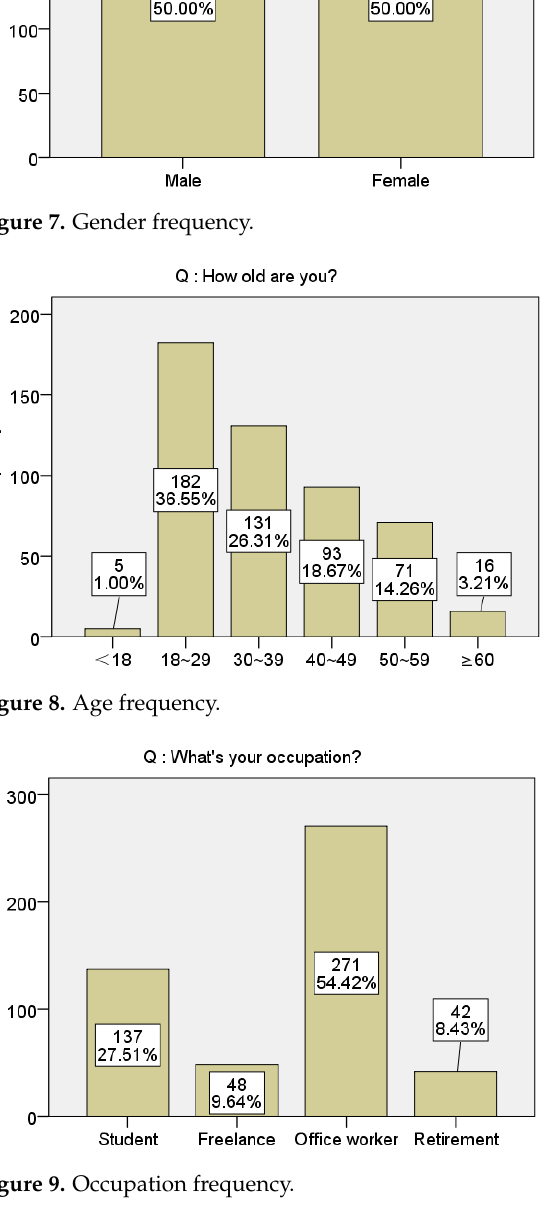
Figure 9. Occupation frequency.